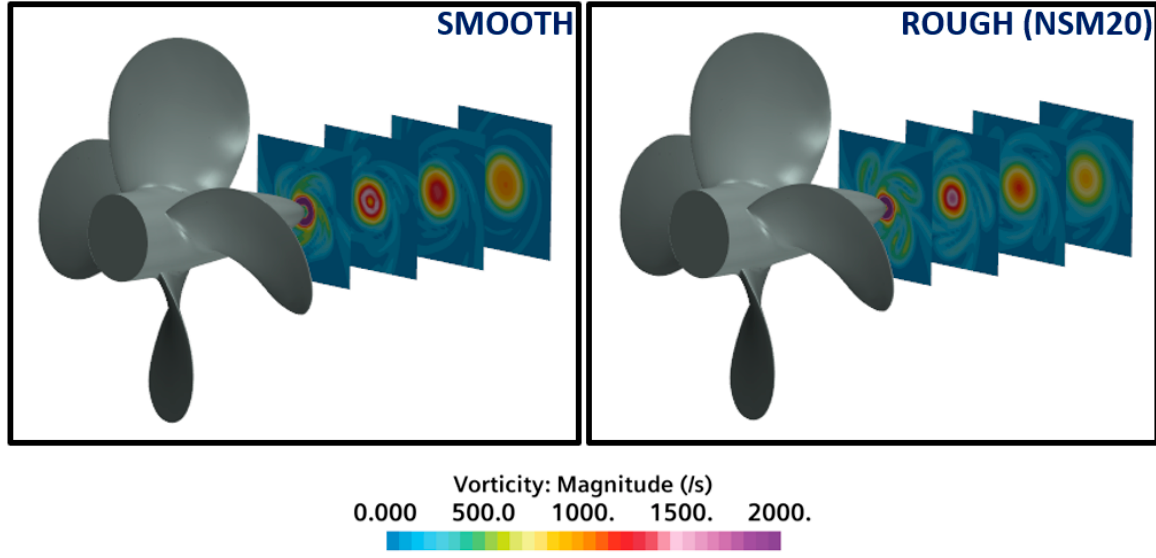
Figure 10. Change in the magnitude of the vortex structures in the propeller slipstream with rough- ness.